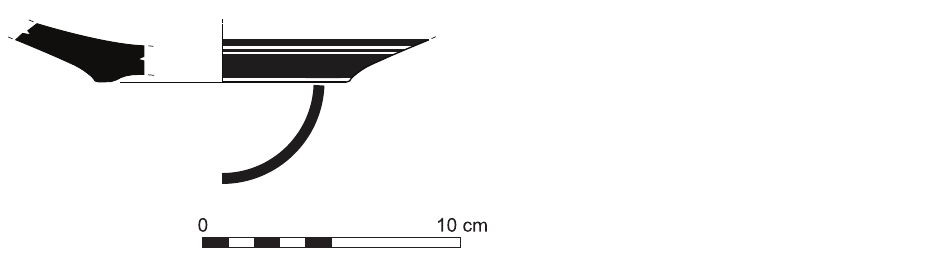
Fig 40. Bottom fragment of a shallow bowl, White Painted II